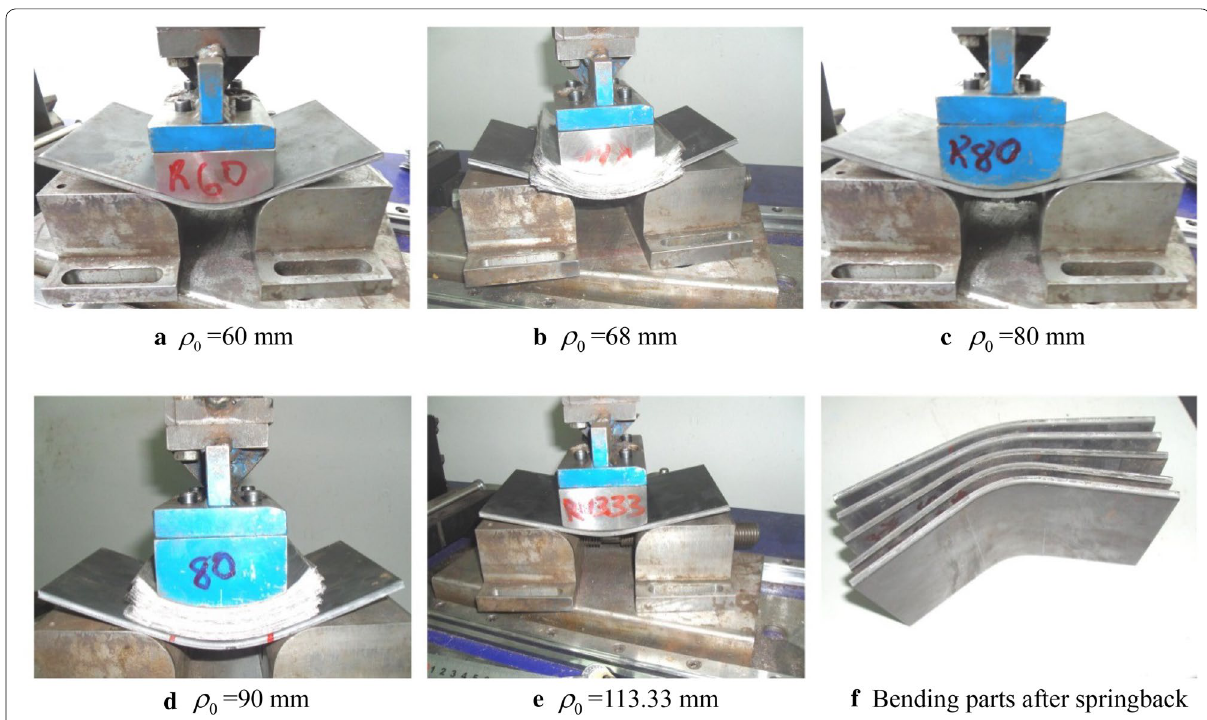
Figure 7 V-free bending process by different equivalent die